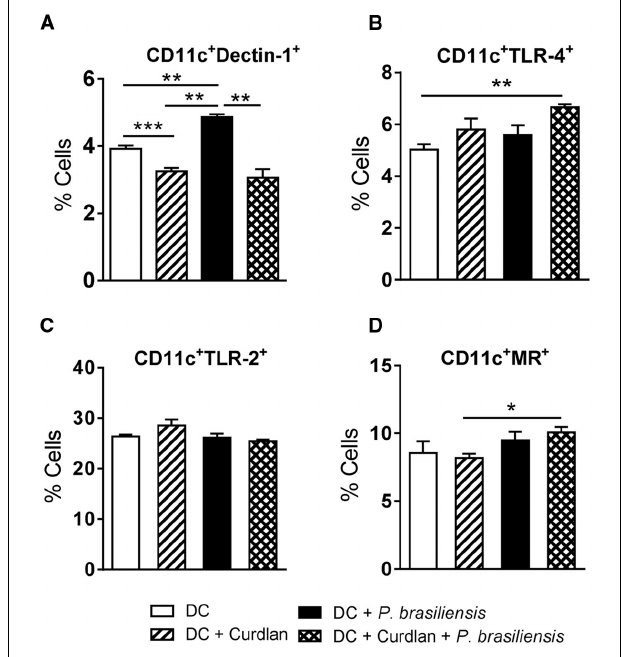
FIGURE 3 | Curdlan regulates the expression of innate immune receptors in P. brasiliensis -stimulated DCs. BMDCs from WT C57BL/6 mice were cultured as previously described. The cells were then treated or not with curdlan (100 m g/ml) for 30 min and infected with viable P. brasiliensis yeasts overnight. The cells were adjusted to 1 (cid:2) 10 6 , labeled with specific anti-CD11c, Dectin-1, TLR-2, TLR-2, and MR antibodies and analyzed by flow cytometry. The leukocyte population was gated by FSC/SSC analysis and CD11c + gated cells were analyzed for CD11c + Dectin-1 + (A) , CD11c + TLR-4 + (B) , CD11c + TLR-2 + (C) , and CD11c + MR + expression (D) . The results are expressed as frequency of positive cells. Data are means (cid:6) SD of five wells per group from two independent experiments (* P < 0.05; ** P < 0.01; *** P < 0.001).